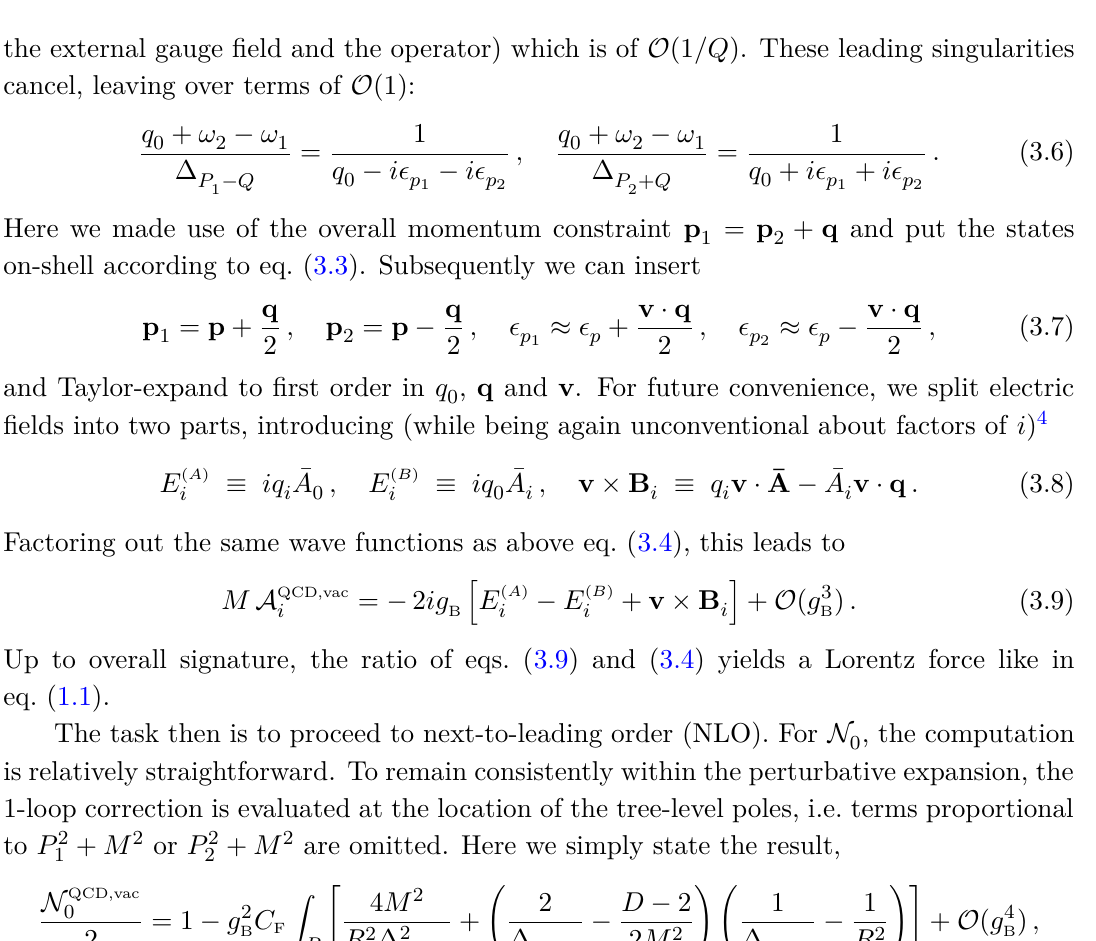
Figure 1 . The LO and NLO graphs contributing to the 3-point correlator in full QCD. A solid line denotes a heavy quark, a curly line an external gauge field, a wavy line a dynamical gauge field, a grey blob a 1-loop gauge field self-energy, a solid circle a mass counterterm, open squares a source and a sink, and a cross the operator related to the conserved current or its time